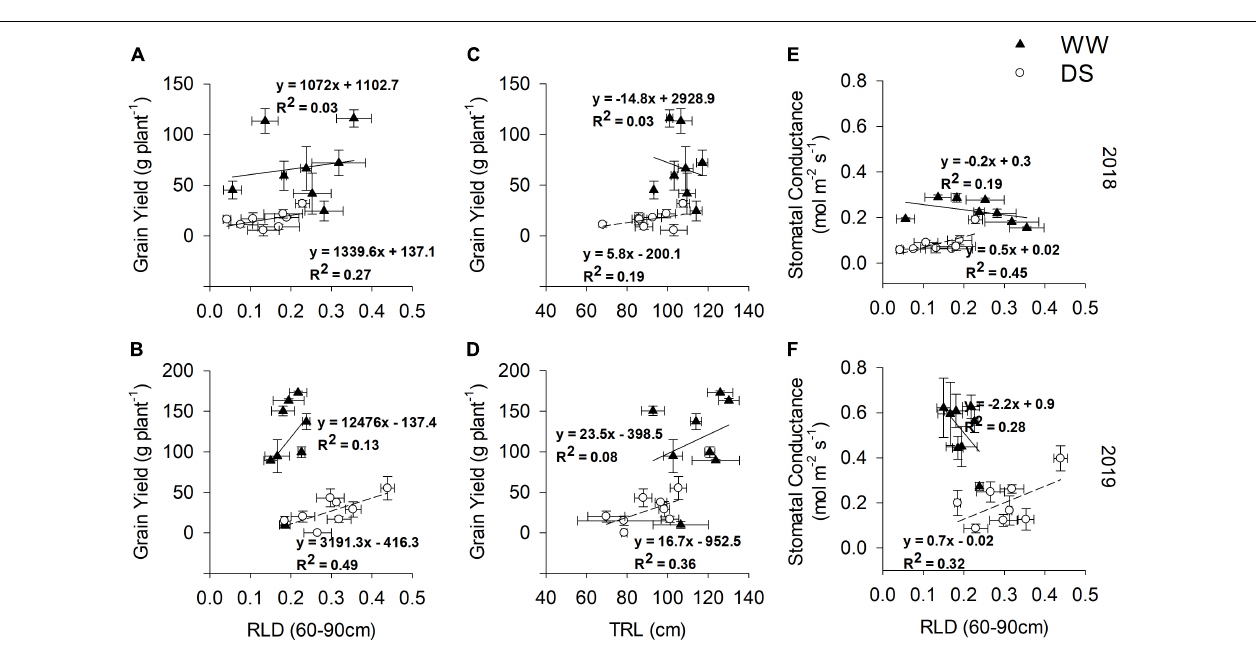
FIGURE 11 | Relationship between RLD (60–90 cm) and grain yield (g plant − 1 ), tap root length (TRL cm) and grain yield (g plant − 1 ), and root length density (RLD 60–90 cm) and g s at 105 DAE, for two seasons: 2018 (A,C,E) and 2019 (B,D,F) under WW and DS. Coefficient of determination R 2 reported upon fitting with equation y = a*x +